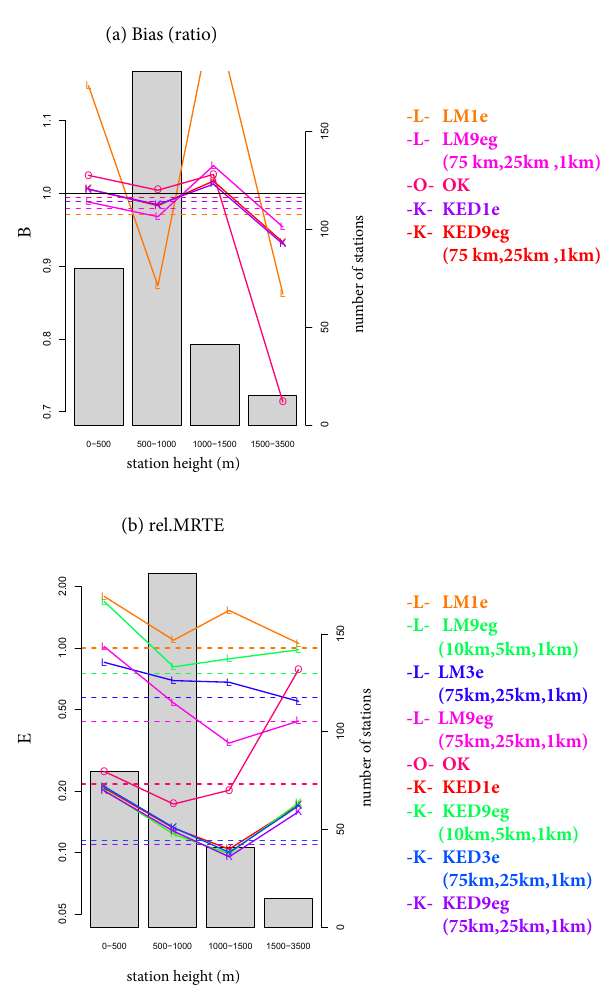
Figure 6. Error statistics for the interpolation of mean DJF precip- itation using different interpolation models (see Table 1 for model acronyms). (a) Relative bias B (dimensionless, Eq. 3) and (b) rel- ative mean root-transformed error E (dimensionless, Eq. 4, log- scale) of a leave-one-out cross-validation. Results are shown for four elevation classes. Horizontal dashed lines represent the scores over all stations. The vertical bars represent the number of stations per elevation class (right axes).